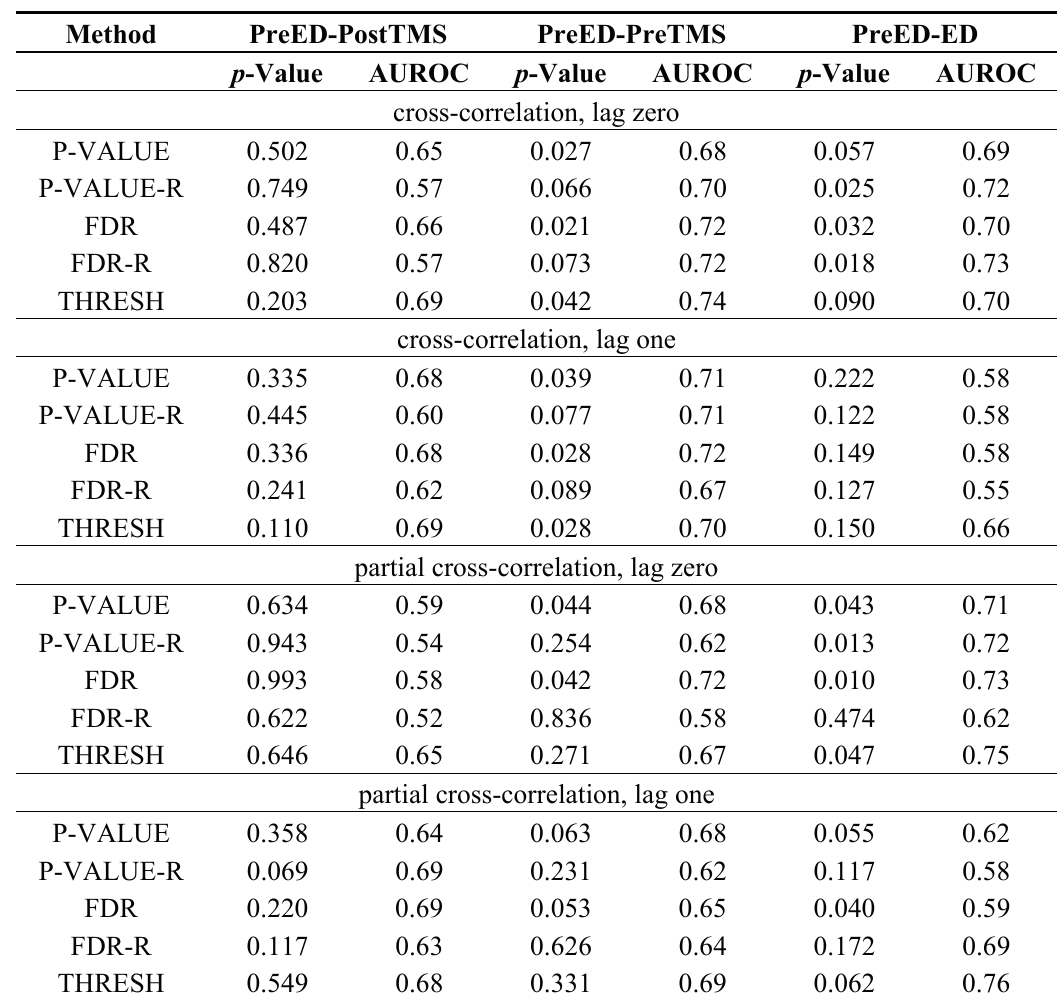
binary networks,